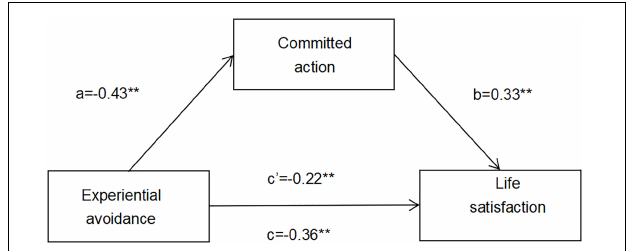
TABLE 6 | Results of the mediated path